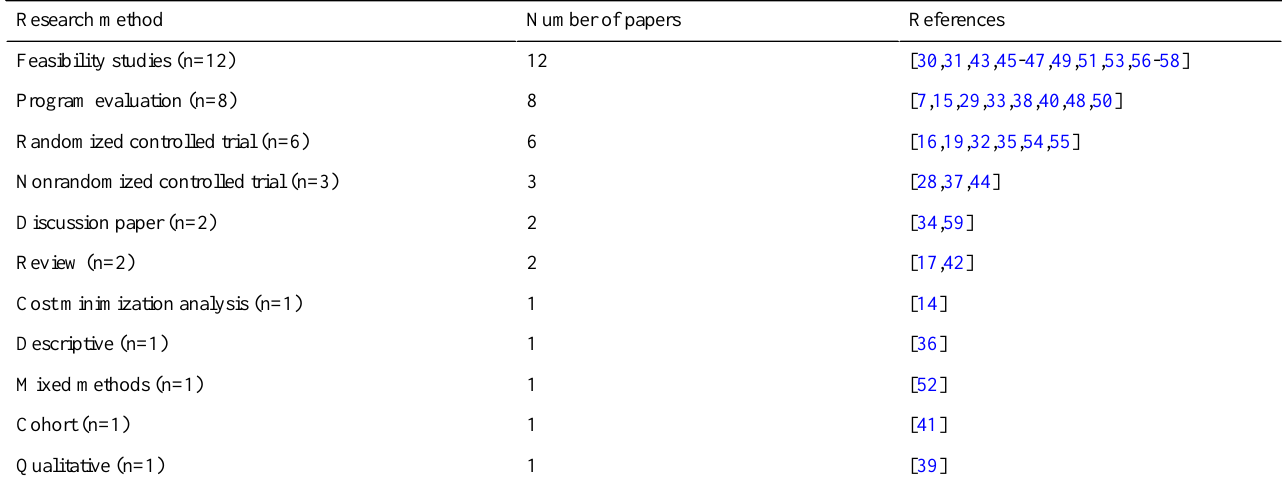
Table 2. Yield of papers by stated research method (N=38).